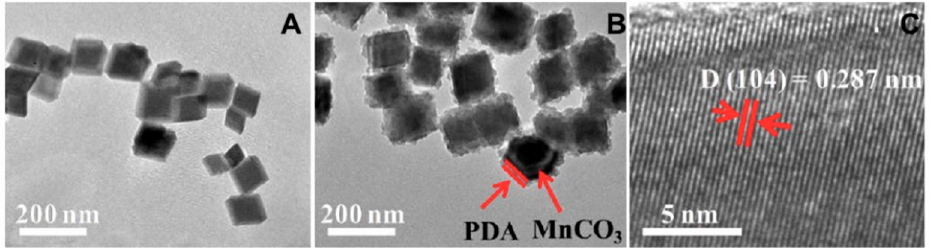
Figure 9. Characterization of the MnCO 3 and MnCO 3 @PDA NPs: ( A ) TEM image of MnCO 3 , ( B ) TEM image of MnCO 3 @PDA, and ( C ) HRTEM image. Reproduced with permission from [73]. Copyright American Chemical Society, 2017.